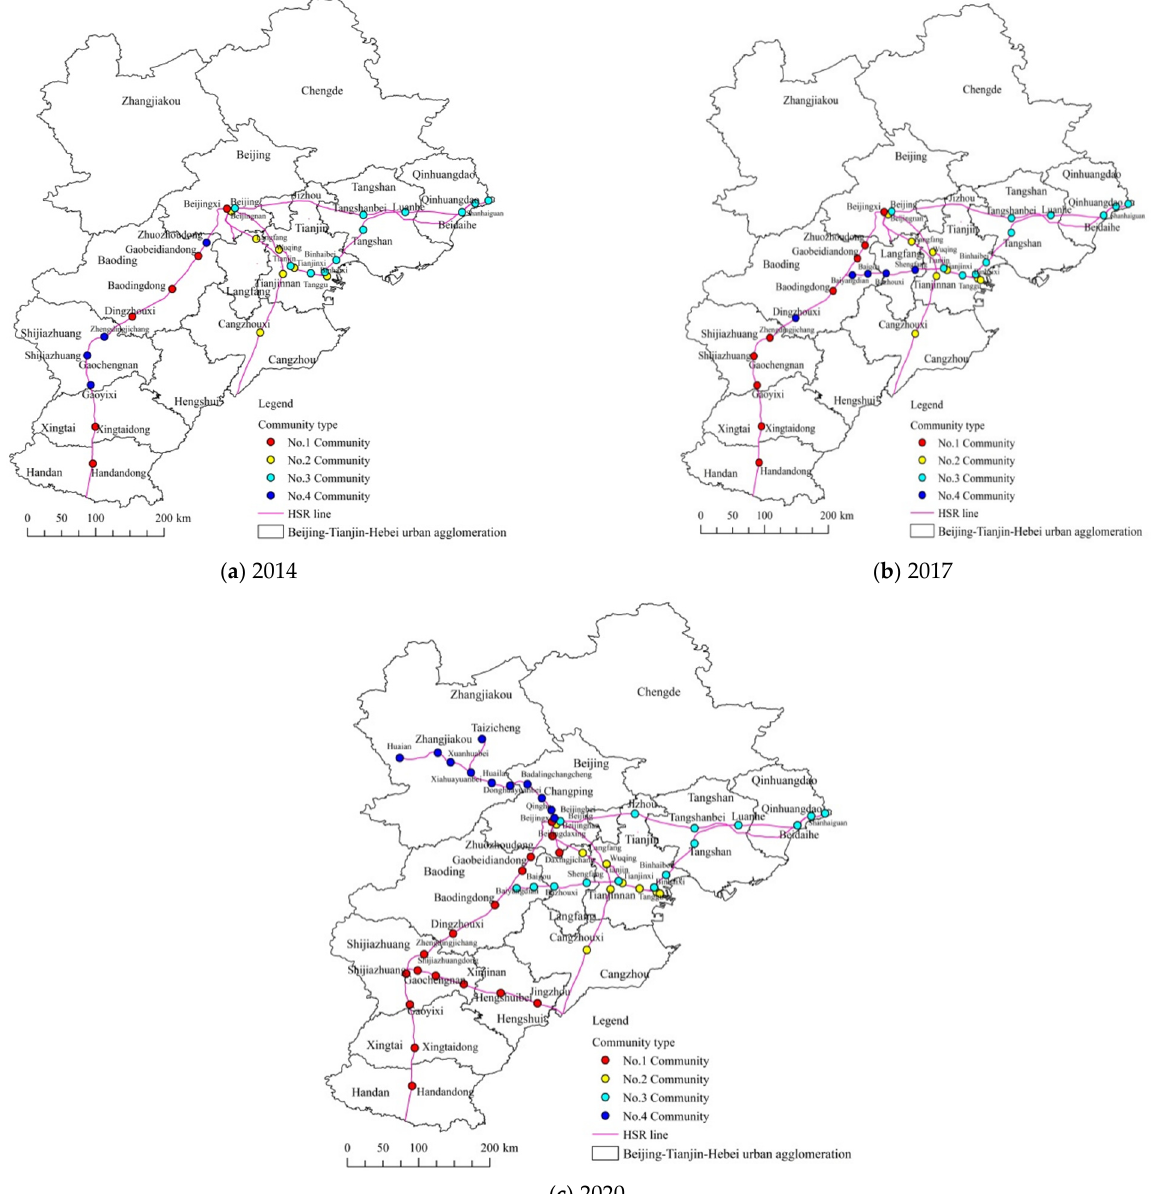
Figure 5. Community structure for the HSR network in the Beijing-Tianjin-Hebei urban agglomeration.